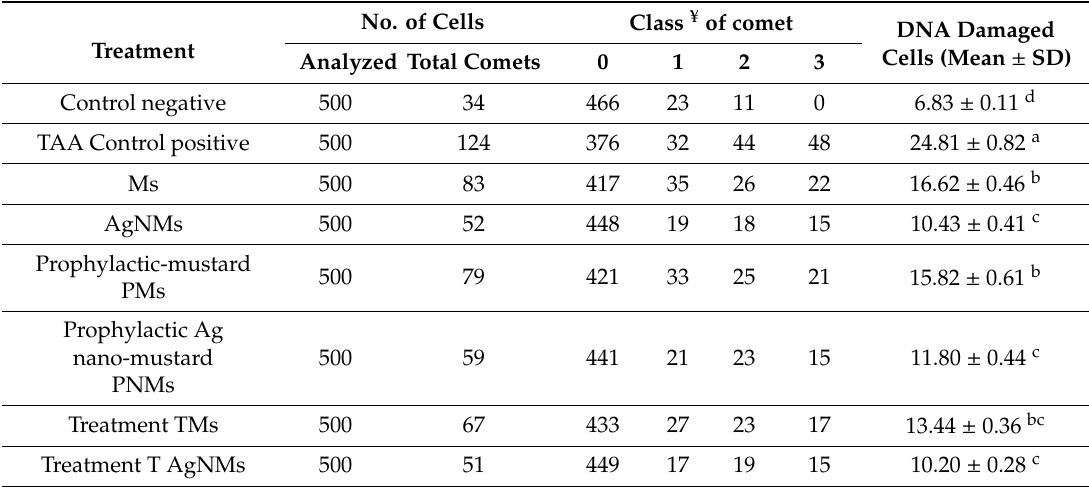
Table 5. E ff ects of Brassica juncea L. (mustard) and its nanoform on DNA degradation. No. of Treatment